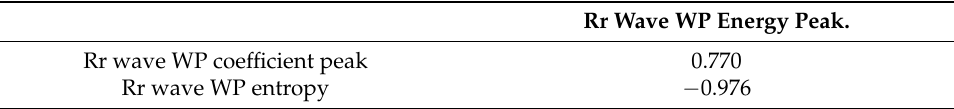
Table 5. Coefficients between the selected parameter and others.